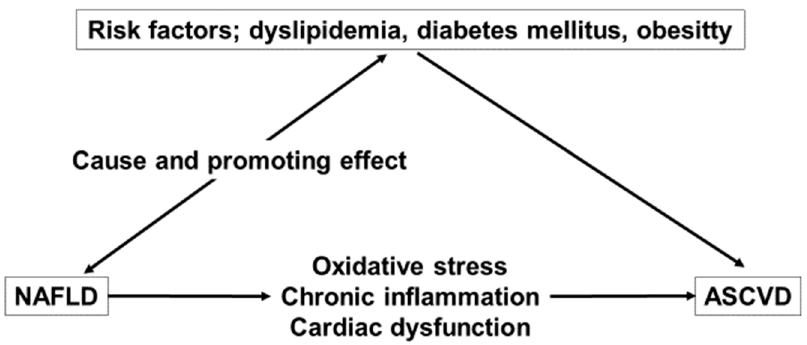
Figure 1. The relationship between NAFLD and ASCVD. NAFLD, non-alcoholic fatty liver disease; ASCVD, atherosclerotic cardiovascular disease.